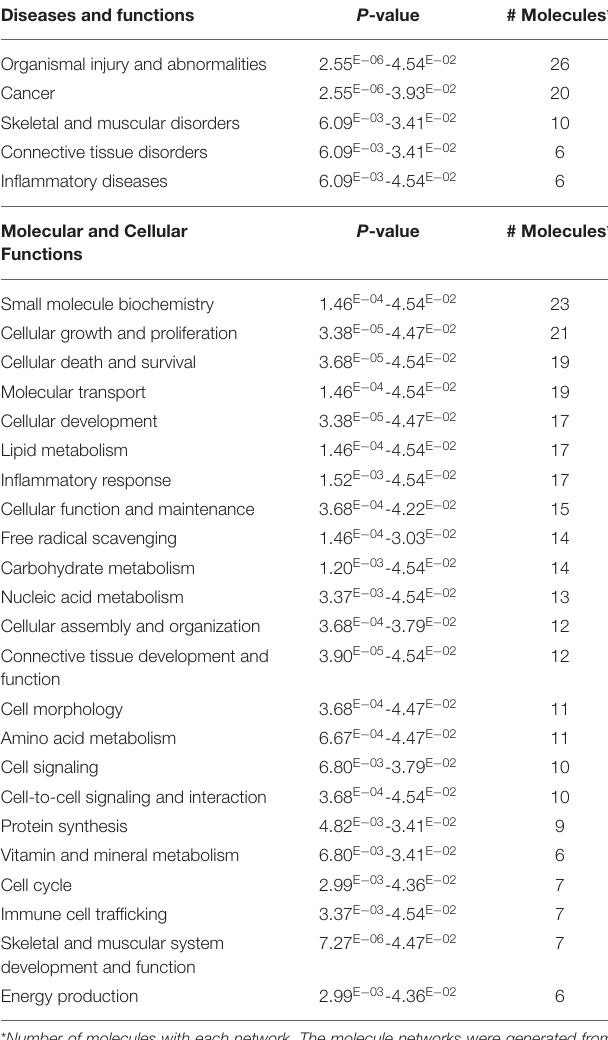
TABLE 4 | Top diseases, molecular, cellular, and physiological functions for DE-metabolites in WB-affected compared to unaffected birds. Diseases and